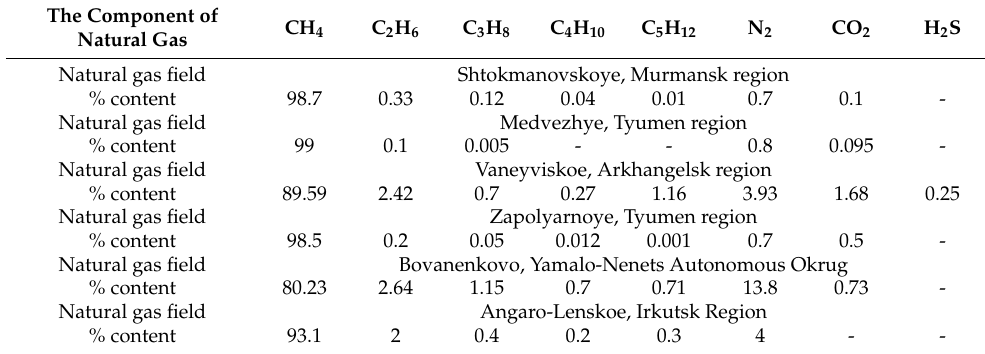
Table 2. Physical characteristics of the natural gas. Composition of the Natural Gas